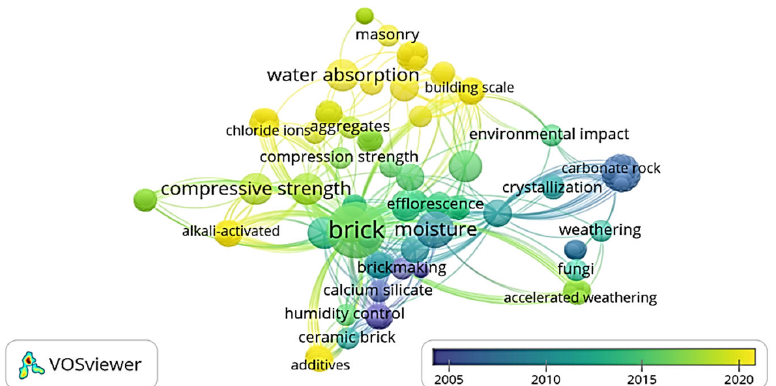
Graphic 2. Map of the analysis of words “brick”, “reduces” and “moisture” with the highest interaction. Source: Obtained from VOSviewer.